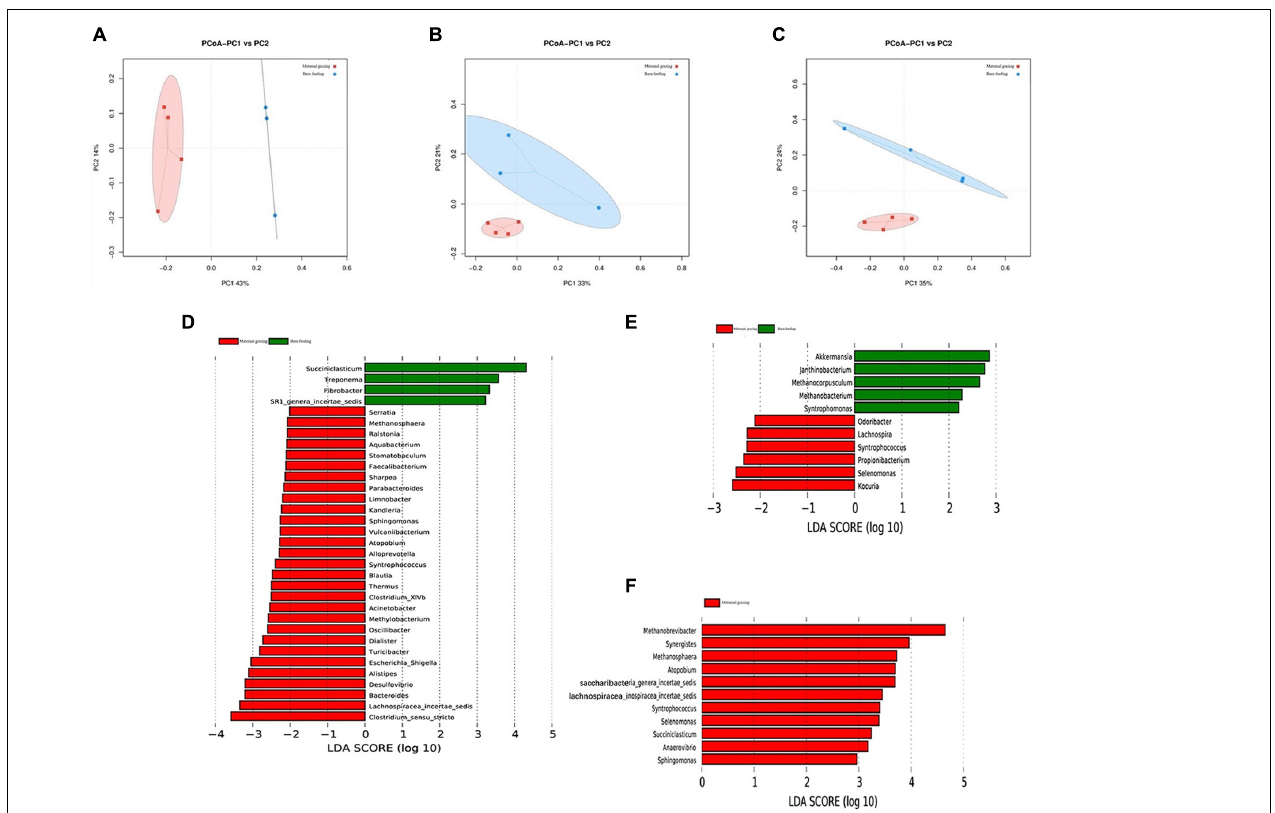
FIGURE 3 | Microbial community difference between the two different feeding strategies (maternal grazing and barn feeding) groups. (A) diversity analyses based on the rumen microbiota; (B) diversity analyses based on the jejunal microbiota; (C) diversity analyses based on the ileal microbiota. (D–F) significantly differential genera based on the linear discriminant analysis effect size (LEfSe) cladogram, and the differences are represented by the color of the